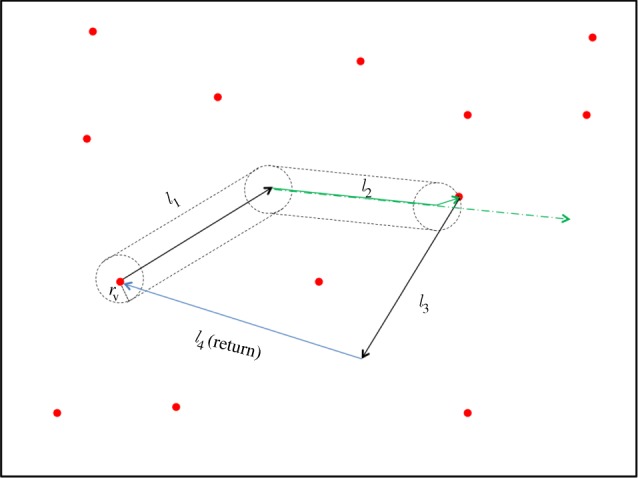
A schematic diagram of the model. This diagram shows a foraging process with N = 4 steps. The red dots represent targets. The cylinder formed by black dashed boundaries indicates the detection area during an exploration step. In step one, the forager leaves a target and detects no new target during this step. Note that the forager ignores the departure target. In step two, the forager decides to undertake exploration and detects a target during this step. Therefore, the original probabilistic step (the green dash-dotted line) is truncated to a shorter actual step l2 (the green solid line). Step three is similar to step one. In step four, the forager decides to return and it flies straight back to the departure target in step one. In a return step, the forager is not attempting to detect targets.